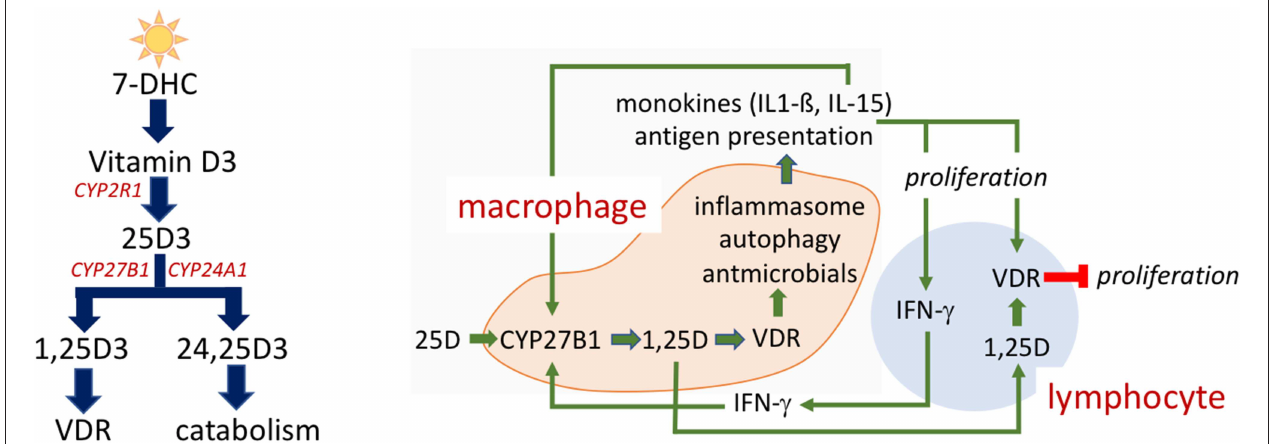
FIGURE 1 | Vitamin D metabolism and action. Vitamin D metabolites (Left) . 7-dehydrocholesterol (7-DHC) is photoconverted to vitamin D 3 by UV exposure of skin. CYP2R1 in the liver hydroxylates vitamin D 3 to 25-hydroxyvitamin D 3 (25(OH)D). Another hydroxylation to 25(OH)D 3 by CYP27B1 occurs in the kidney but also in a number of extra-renal tissues produces the active 1,25-dihydroxyvitamin D 3 (1,25(OH) 2 D 3 ). 1,25(OH) 2 D 3 is the cognate ligand for the vitamin D receptor (VDR), a nuclear transcription factor, that directs 1,25(OH) 2 D 3 regulated gene transcription. CYP24A1 is responsible for the hydroxylation that yields 24,25-dihydroxyvitamin D (24,25(OH) 2 D 3 ) and subsequent catabolism to non-biologically active metabolites. Intracrine mechanism in immune cells (Right) . Vitamin D action in immune cells is reliant upon the intracrine (local) production of active 1,25(OH)2D within the macrophage. Vitamin D status of the host as defined by serum, extracellular 25(OH)D levels impact immune response, as 25(OH)D is the substrate for CYP27B1. A complex interplay between monokine signaling, that can both be responsive to and stimulatory of 1,25(OH) 2 D synthesis, and regulatory signaling among innate and adaptive immune cells is shown.